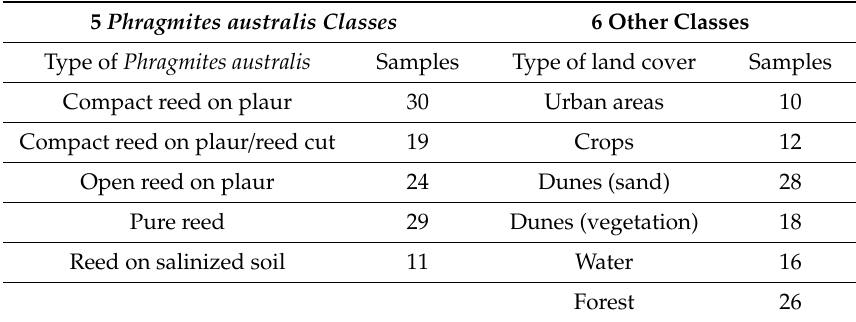
Table 2. On the left the reed classes and the number of samples per class. On the right the other land cover classes and their